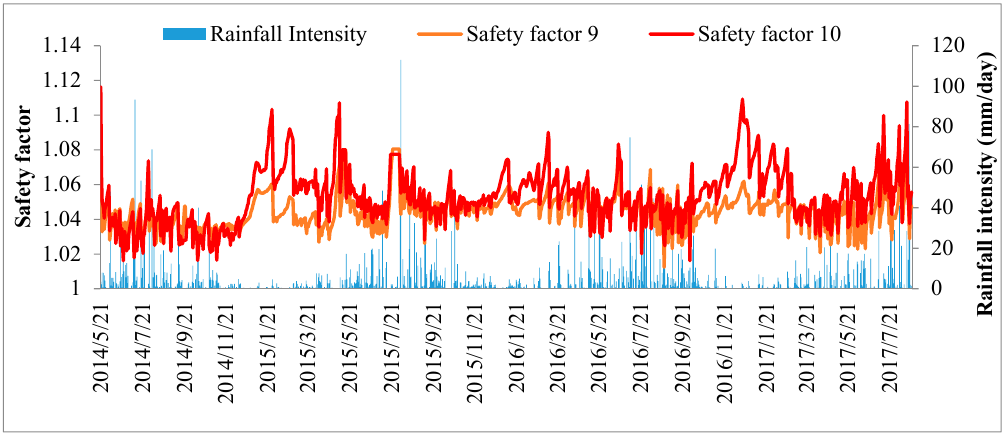
Figure 8. Modeled factors of safety based on fluctuation of suction stress for different position in the slope during 21 May 2014 to 22 August 2017.